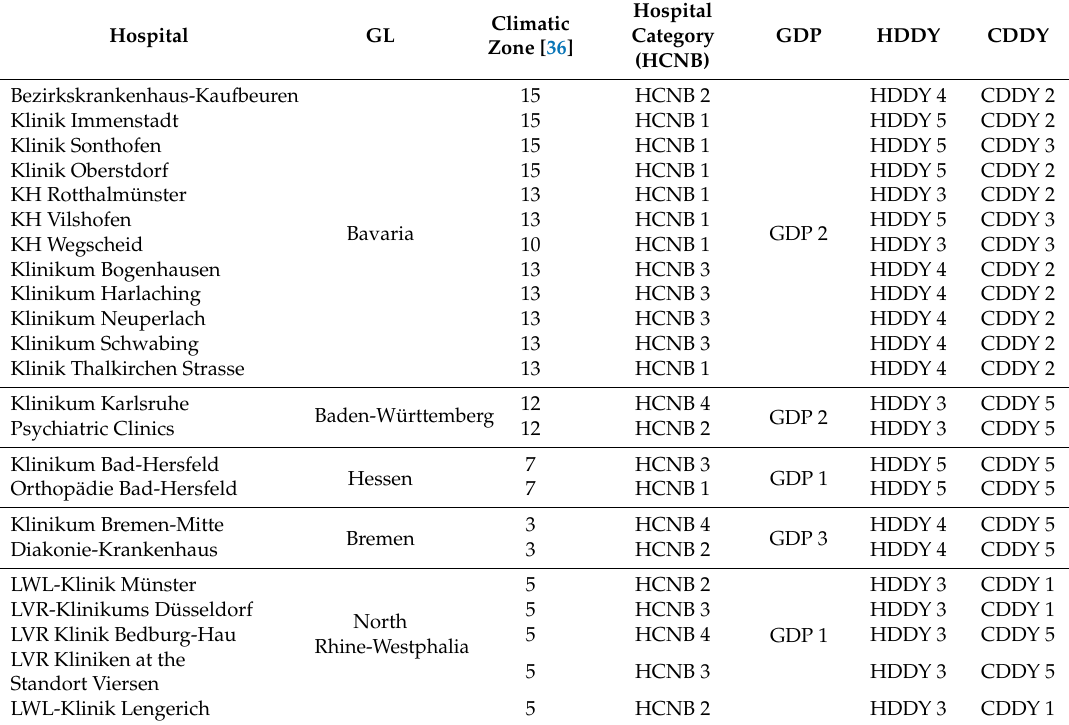
Table 4. List of hospitals analyzed with the distribution by